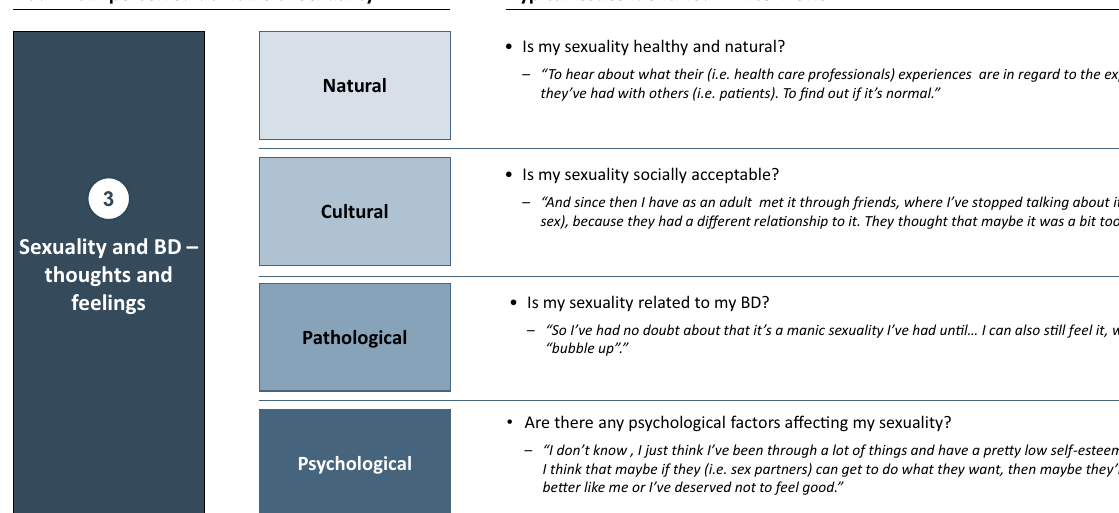
Fig. 2 Perceived domains of sexuality based on the qualitative interviews with individuals with